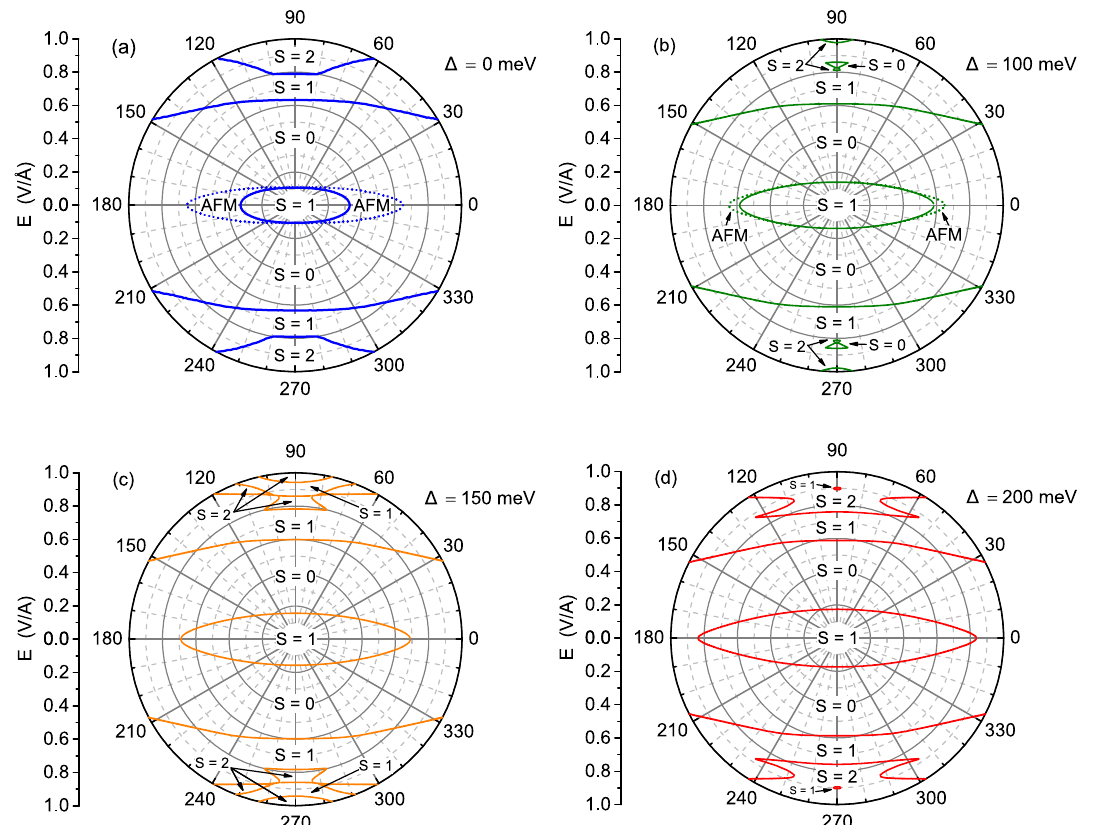
Figure 2. The ground-state magnetic phase diagram for the electric fields of magnitude not exceeding 1 V/Å and arbitrary in-plane orientation. Four values of exchange energy are selected: 0 meV ( a ), 100 meV ( b ), 150 meV ( c ), and 200 meV ( d ). The borders of phases with various values of total spin S are marked with solid lines. The dashed lines delimit the antiferromagnetic (AFM) and non-magnetic (NM) phase for S =